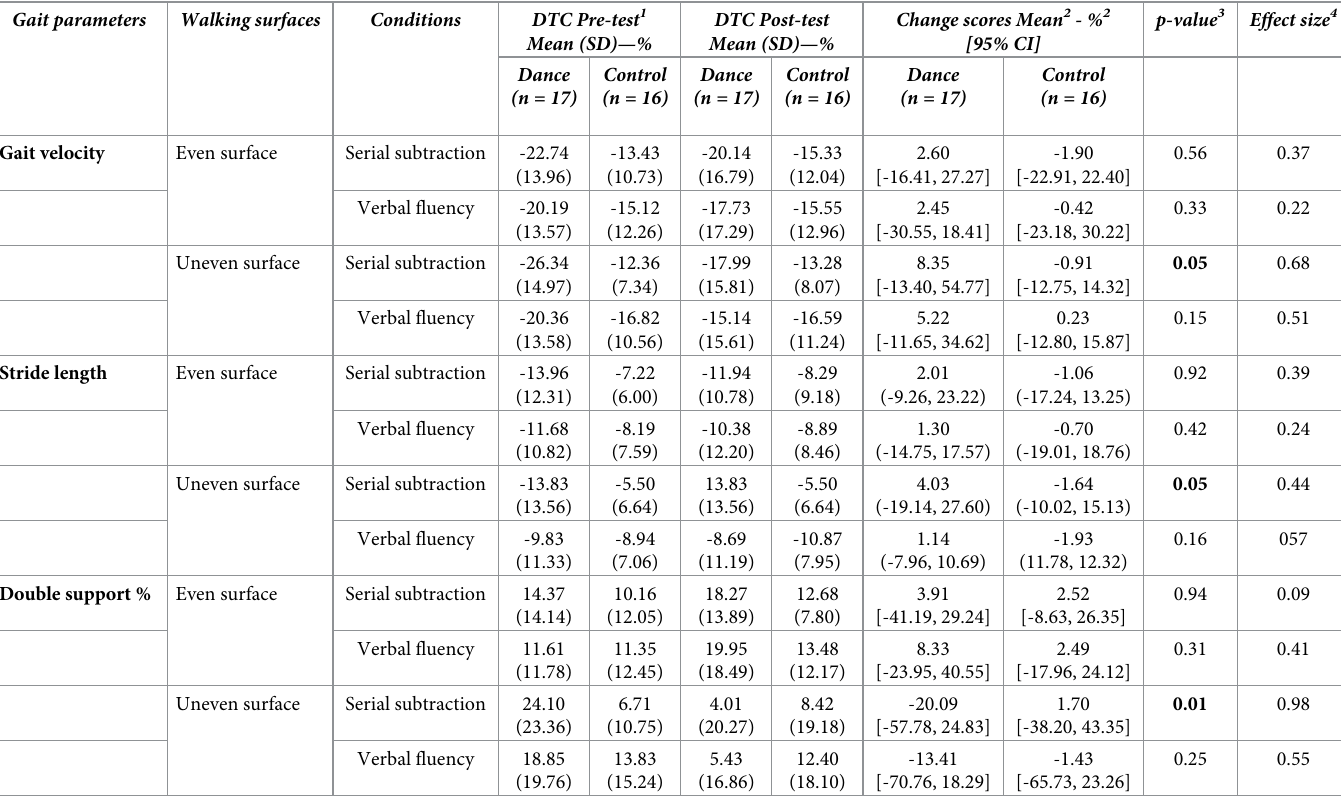
Table 4. Calculation of dual task cost for gait variables during verbal fluency task and serial subtraction tasks on even surface and uneven surface. Gait parameters Walking